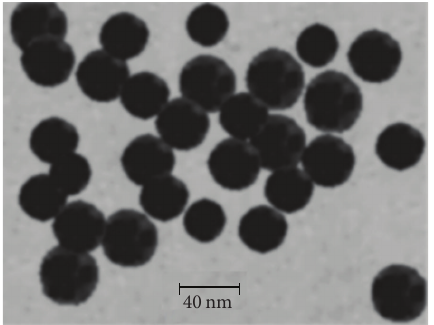
F 5: TEM image of calcined catalyst containing 20wt.